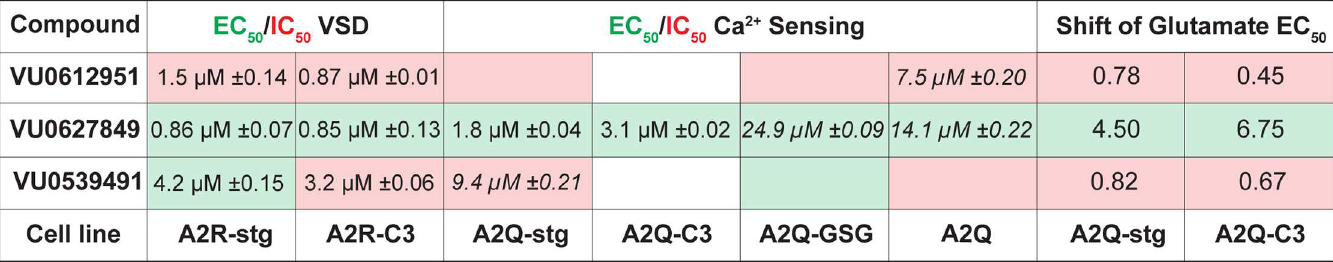
PLOS ONE | https://doi.org/10.1371/journal.pone.0174742 March 30,